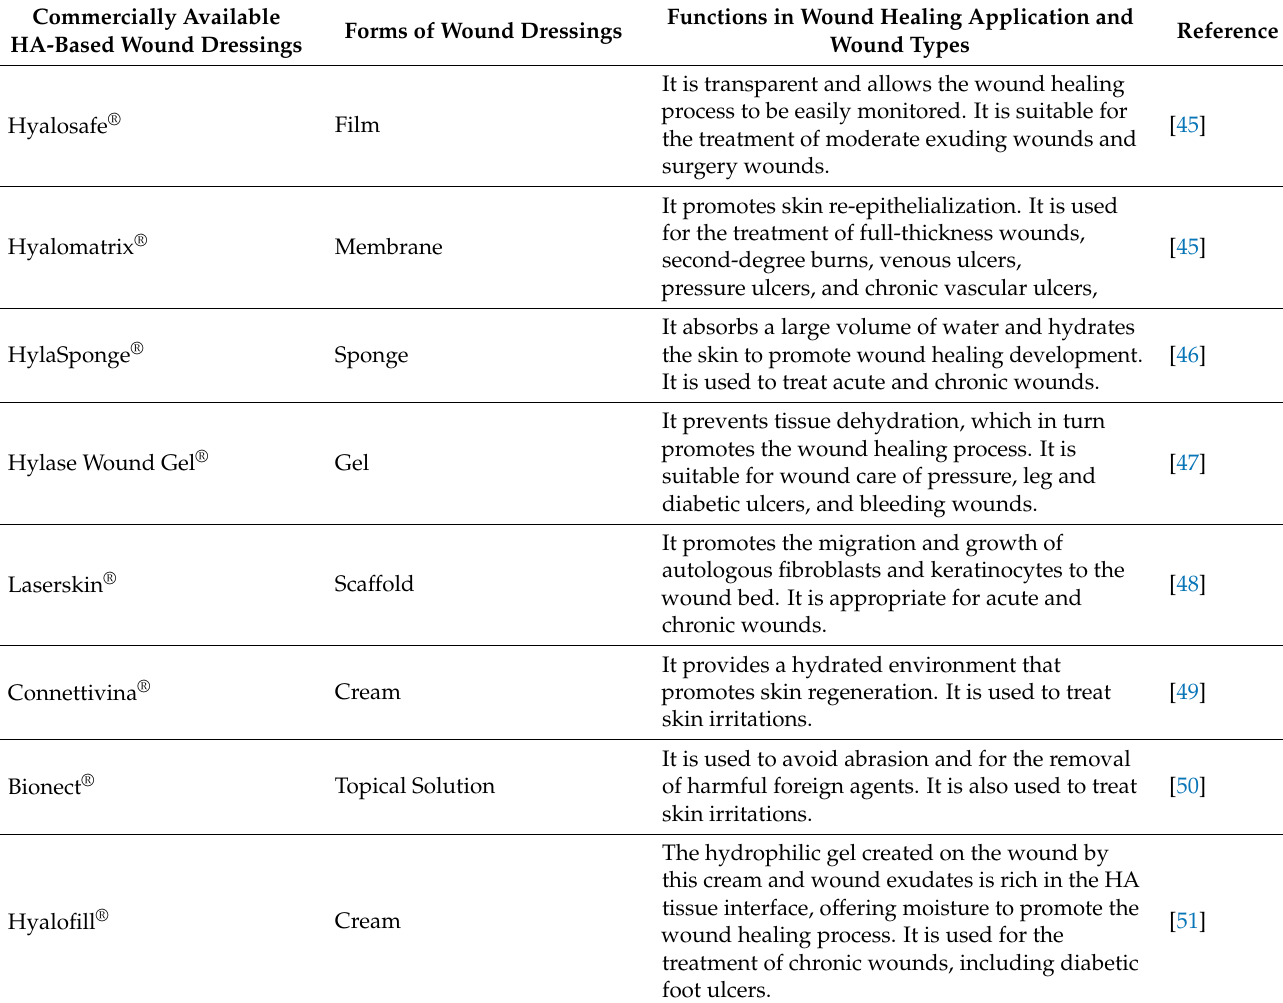
Table 2. Commercially available HA-based scaffolds for wound dressing and their specific functions. Commercially Available HA-Based Wound